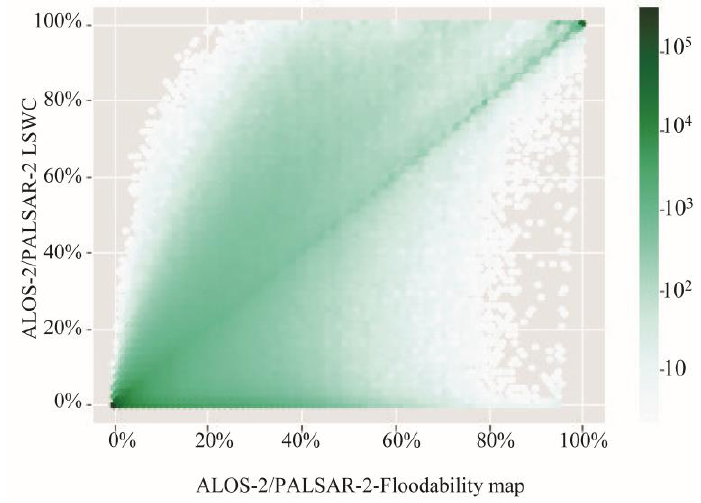
Figure 12. The relationship between the ALOS-2/PALSAR-2 floodability (ratio between cumulative ALOS-2/PALSAR-2 LSWC divided by the cumulative ALOS-2/PALSAR-2 observation times) and the ALOS-2/PALSAR-2-LSWC. The color bar indicates the pixel counts of each plot (collected at a 1 km spatial resolution).